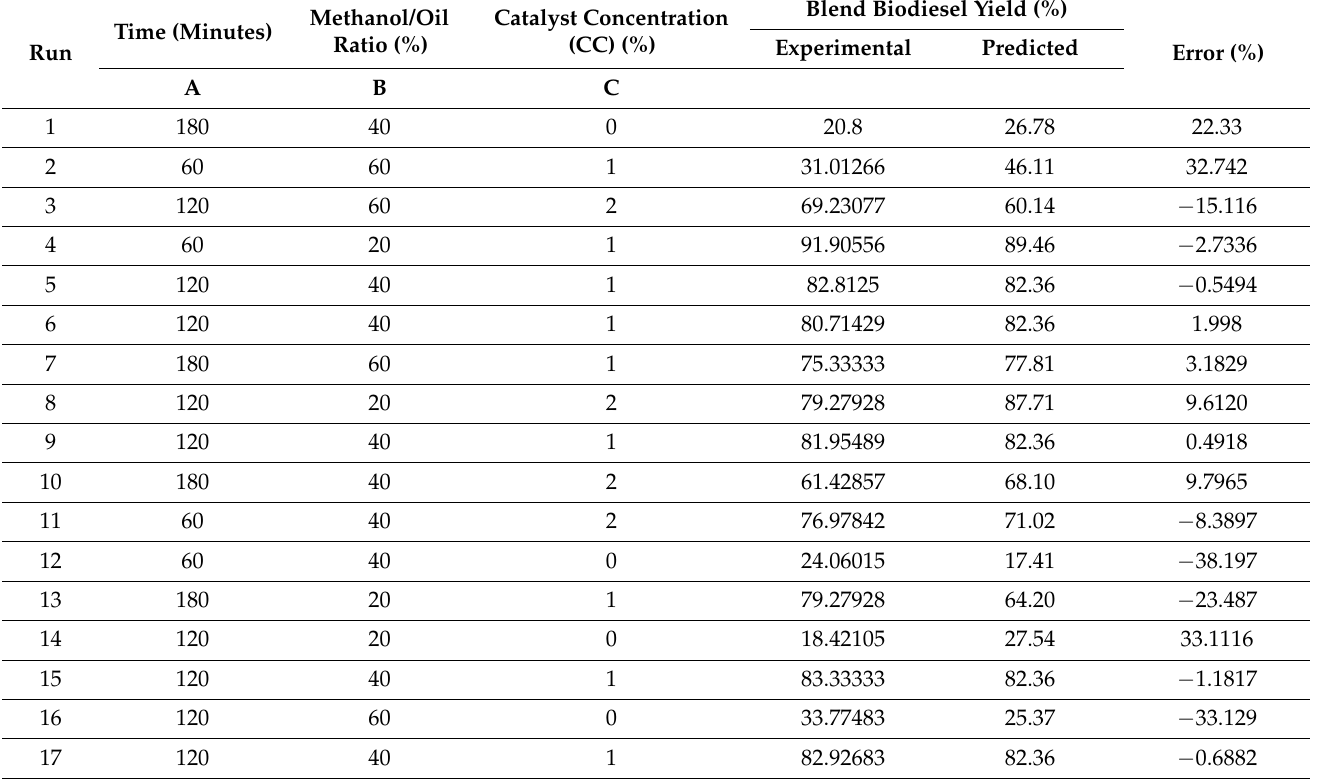
Table 4. Observations to the combination of waste cooking oil and algae oil being